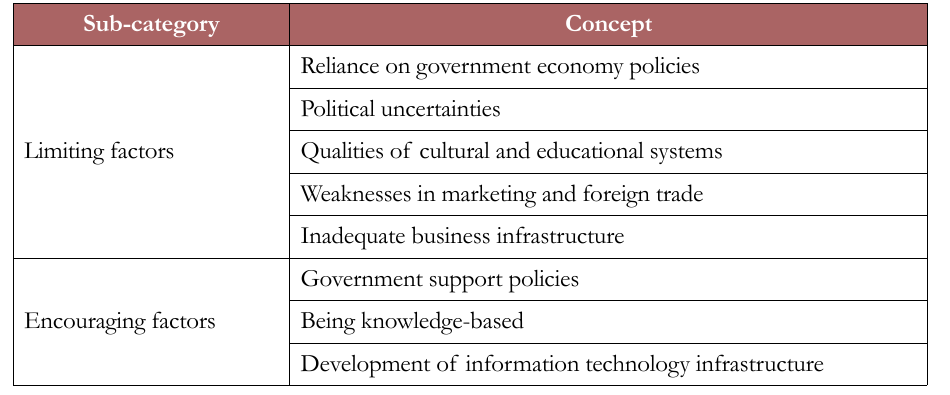
Table 5. Concepts and sub-categories of contextual